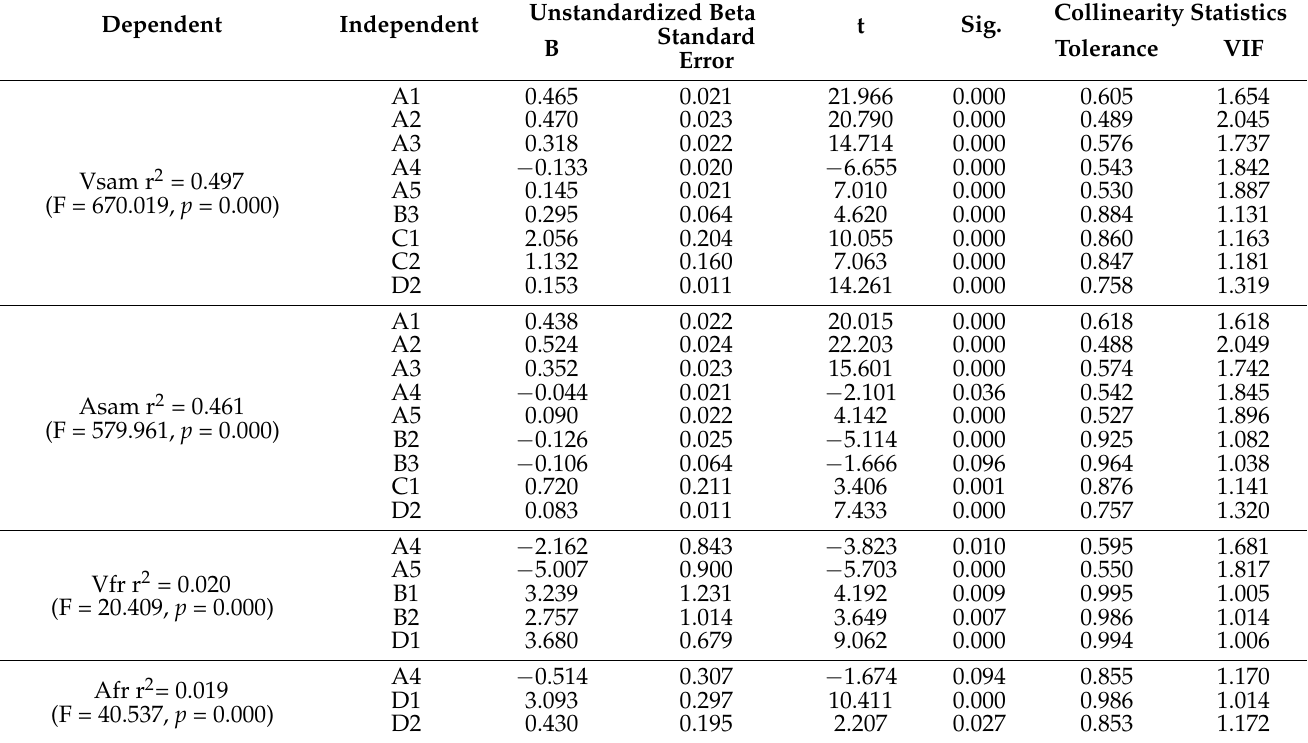
Table 3. Linear regression analysis of the spatial quality and emotional